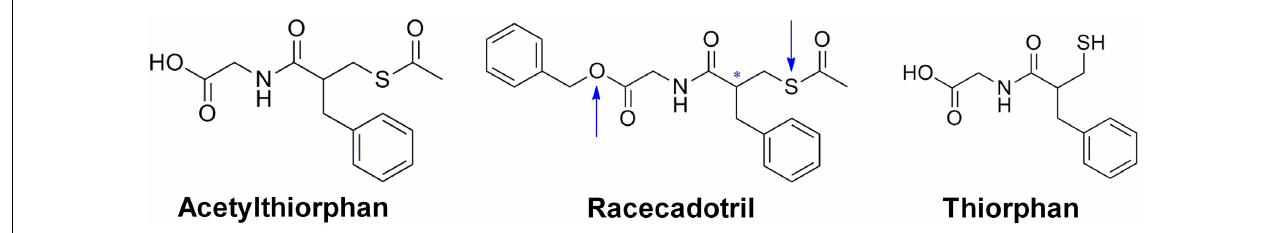
FIGURE 1 | Chemical structures of racecadotril and its two metabolites thiorphan and acetyl-thiorphan. The blue arrows indicate the sites of metabolization; the asterisk indicates the chiral center of the molecule.